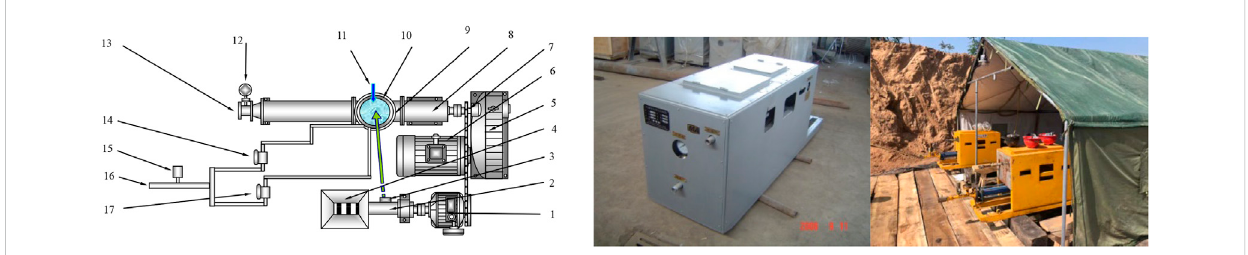
Frontiers in Earth